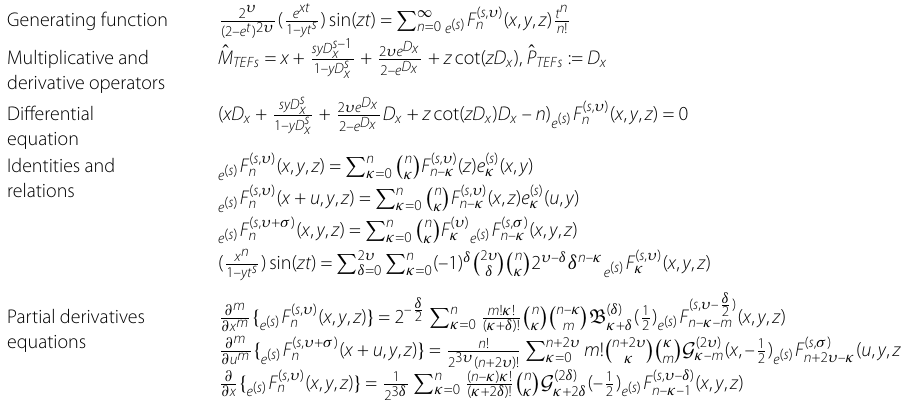
F ( s , υ ) n ( x , y , z ) e ( s )